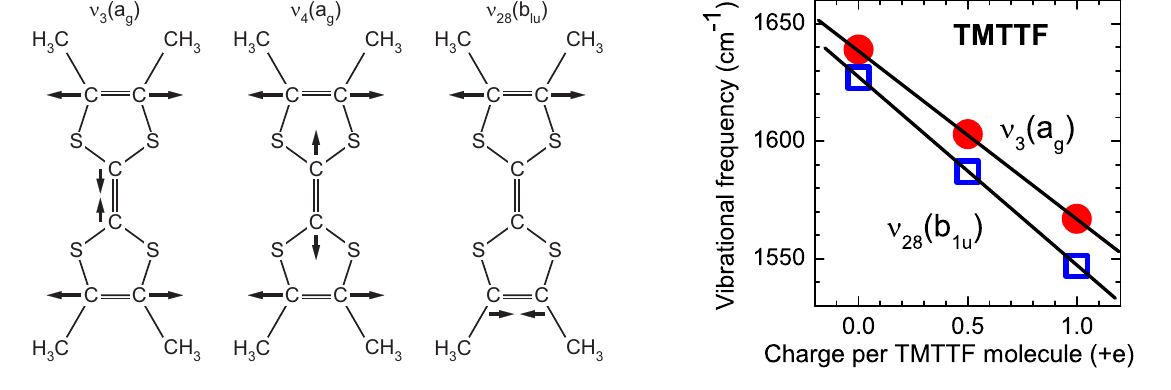
Figure 3. Sketch of the totally symmetric a stretching modes of the TMTTF molecule that mainly involve the central and outer C = C bonds. In the right frame, we show the linear shift of the intramolecular vibrations ν ( b ) with the charge per TMTTF molecule obtained from optical spectroscopy by and ν 28 1 u Meneghetti et al.